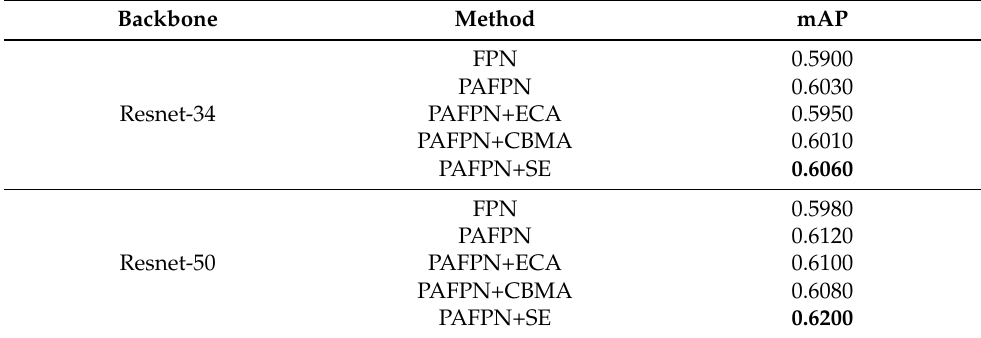
Table 4. The performance of different attention mechanisms on the NWPU VHR-10 dataset.